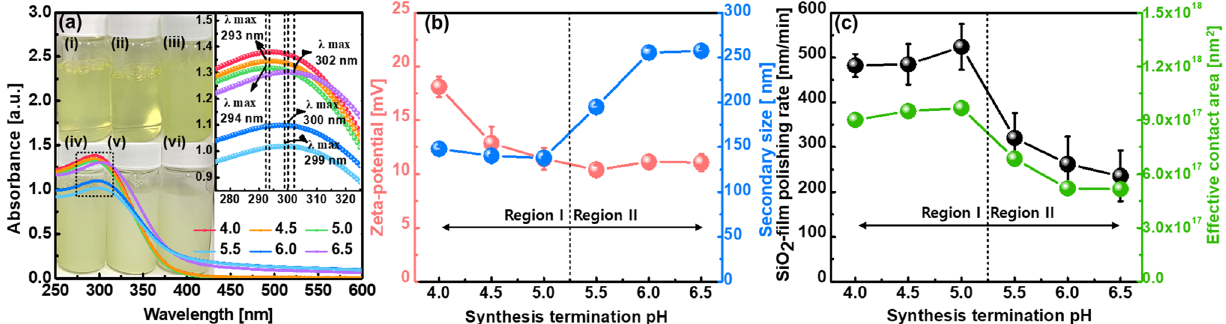
Figure 4. CMP slurry characteristics and CMP performance dependent on synthesis termination pH. ( a ) Peak absorption wavelength and absorbance, ( b ) abrasive zeta potential and secondary abrasives size, and ( c ) SiO 2 - film polishing rate and effective contact area between abrasives and SiO 2 -film surface. In ( a ), the CMP slurries in beakers (i), (ii), (iii), (iv), (v), and (vi) were terminated at pH values of 4.0, 4.5, 5.0, 5.5, 6.0, and 6.5, respectively, following a